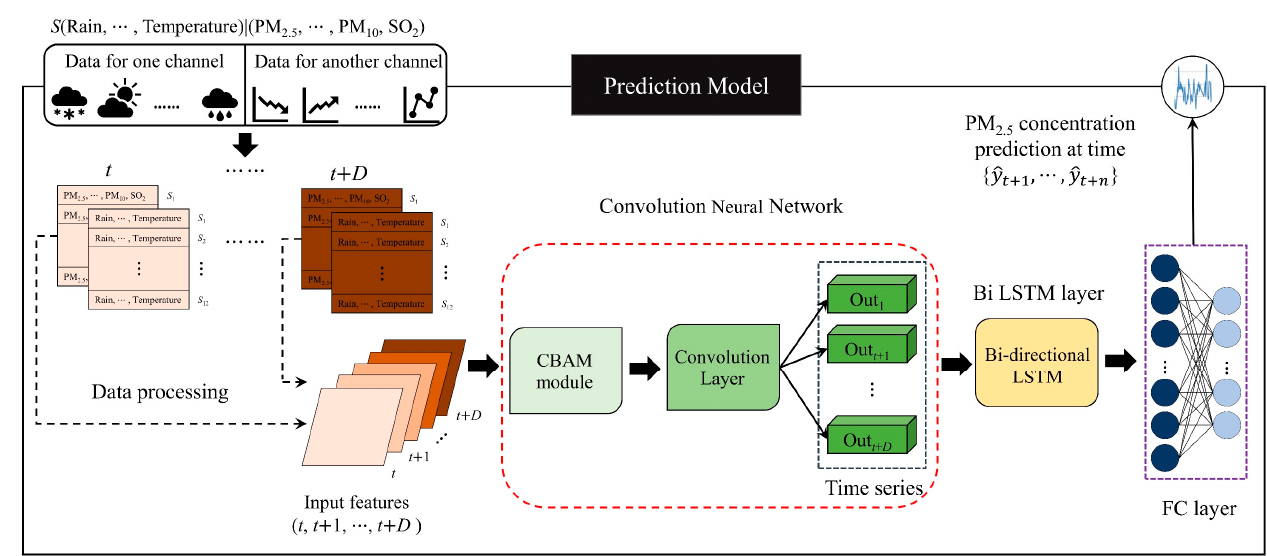
Figure 2. The architecture of CBAM-CNN-Bi LSTM.